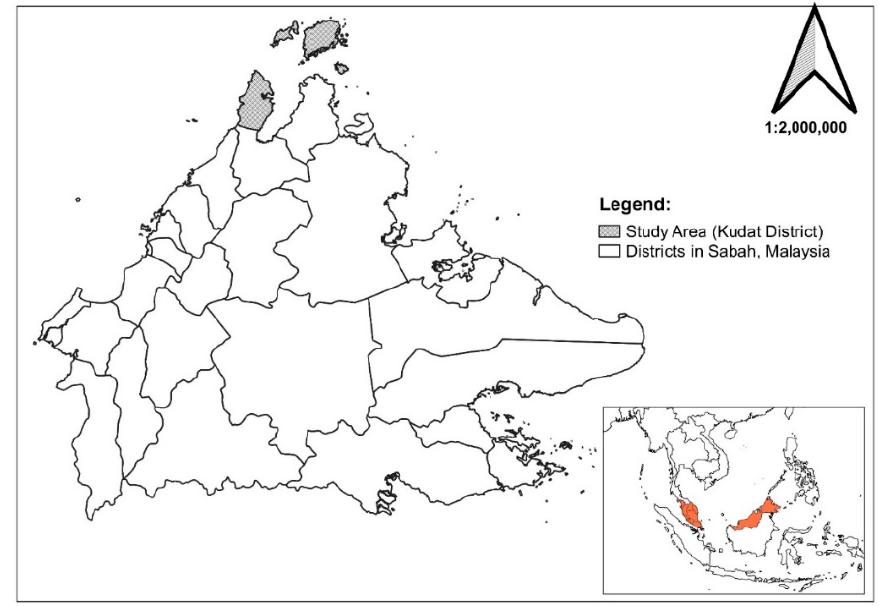
Figure 4. Map of the Kudat district.